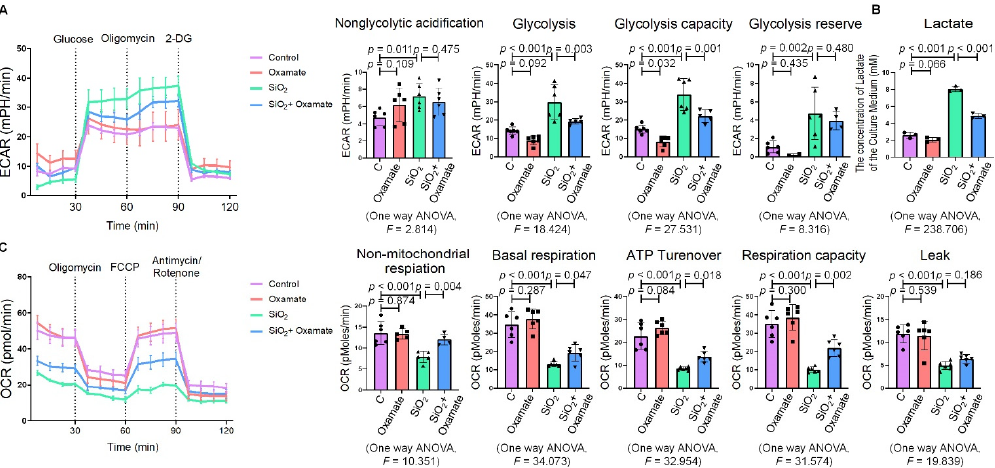
Figure 3. Oxamate attenuated the enhancement of glycolysis in silica-induced macrophages. ( A ) Glycolysis flux was examined by measuring the ECAR using the Seahorse analyzer. Data are presented as the mean ± SD, n = 6 per group. ( B ) The lactate concentration in the culture medium was detected using a lactate assay kit. Data are presented as the mean ± SD, n = 3 per group. ( C ) The OCR values were measured using the Seahorse analyzer. Data are presented as the mean ± SD, n = 6 per